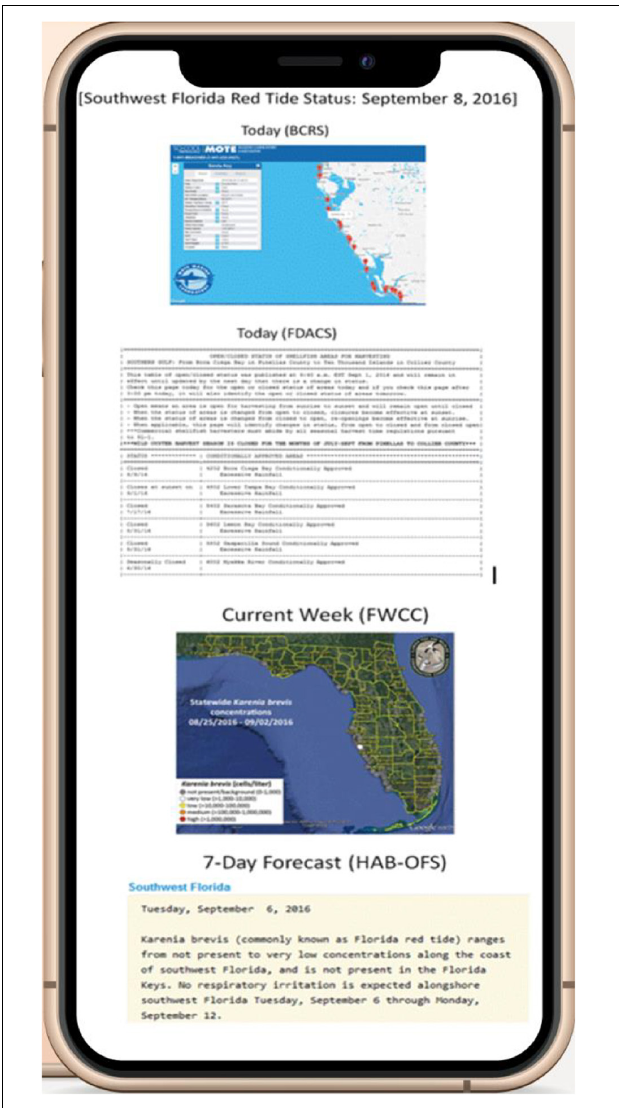
FIGURE 3 | A prototype of a mobile device display showing a combination of user-friendly notifications from four disparate public services, providing information about current status and forecasts of Florida red tides. (All images were compiled between 3 pm and 4 pm EST on September 8, 2016.) Some challenges include varying issue dates and vintages of information; the use of maps of different resolutions and projections; varying degrees of difficulty in interpreting the notifications; and varying degrees of difficulty in gaining access to information at different web locations. These challenges may contribute to a social amplification of risk concerning Florida red tide blooms, implying that the hazard and its social and economic costs are larger than